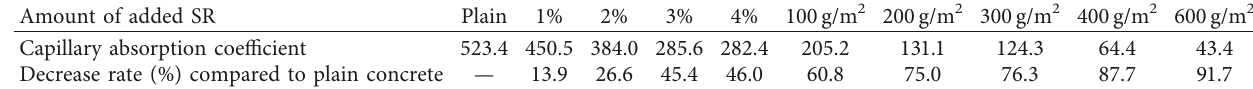
Table 3: Capillary water absorption coefficient and decrease rate of C-ISR and C-SSR.